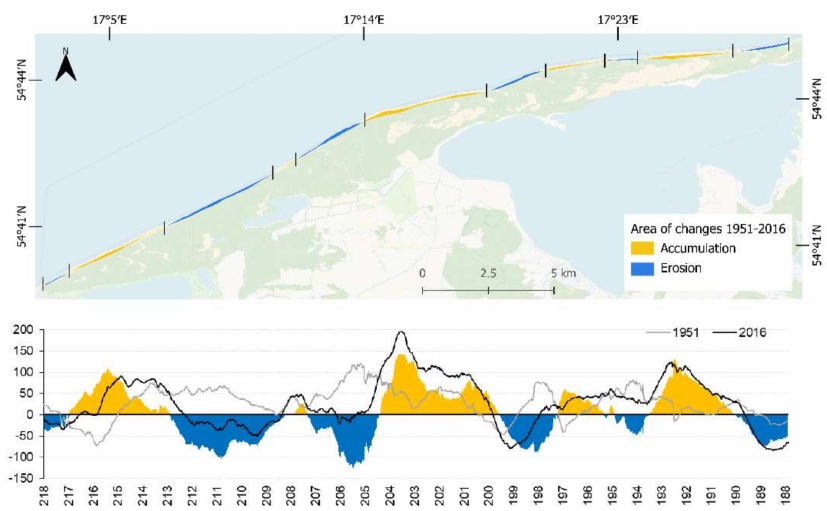
Figure 10. Map of total change in the shoreline from 1951 to 2016. The base